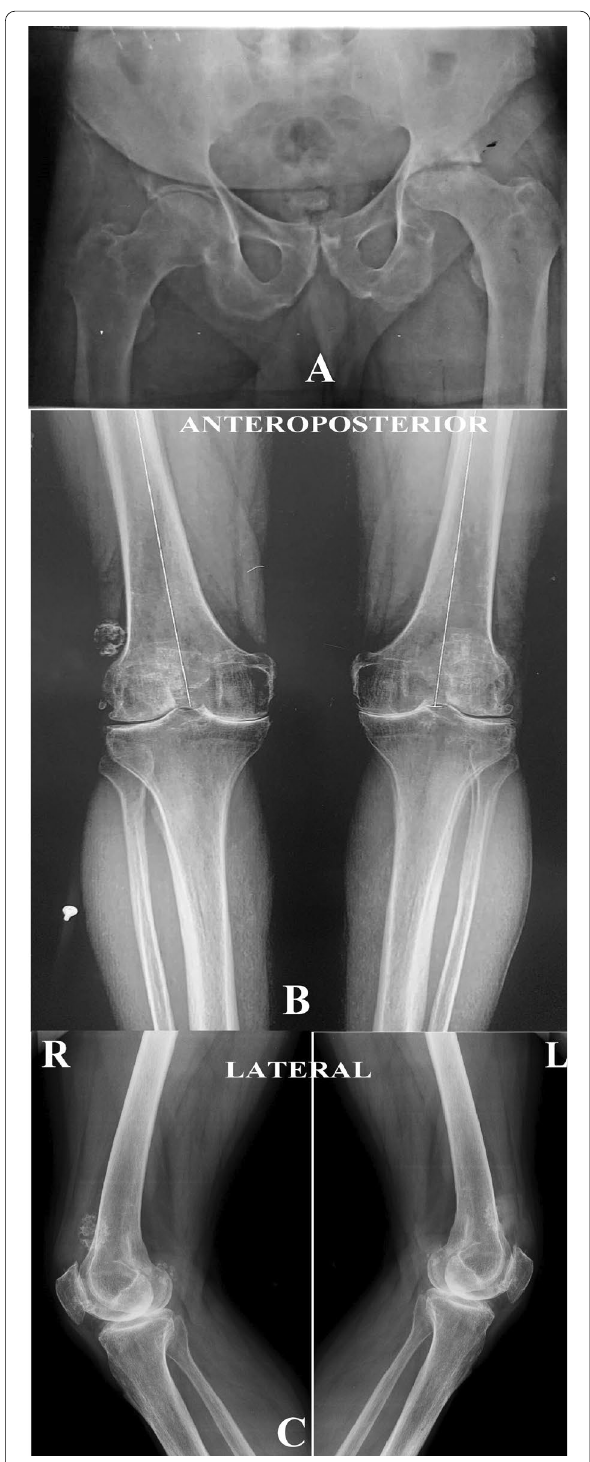
Fig. 2 Preoperative plain radiographs: A Anteroposterior view of the pelvis showing hip joints bilaterally with a collapse of the left femoral head and advanced osteoarthritis. B and C anteroposterior and lateral views of the knee joint bilaterally showing reduction of the joint space, varus deformity and advanced